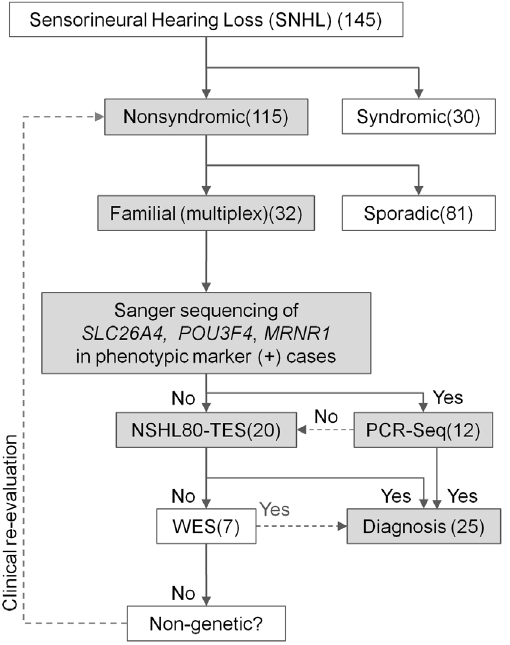
Figure 4. Proposed decision procedure for the genetic diagnosis of familial NSHL. We have recruited 145 sensorineural hearing loss patients, Among 115 NSHL cases, we started with 32 familial NSHL because we could check the inheritance patterns in the family. First, we excluded 12 cases with typical clinical features by PCR- Sanger sequencing. In the remaining 20 familial NSHL probands, we found candidate SNVs in 13 probands. In further study, we can find SNVs by whole exome sequencing